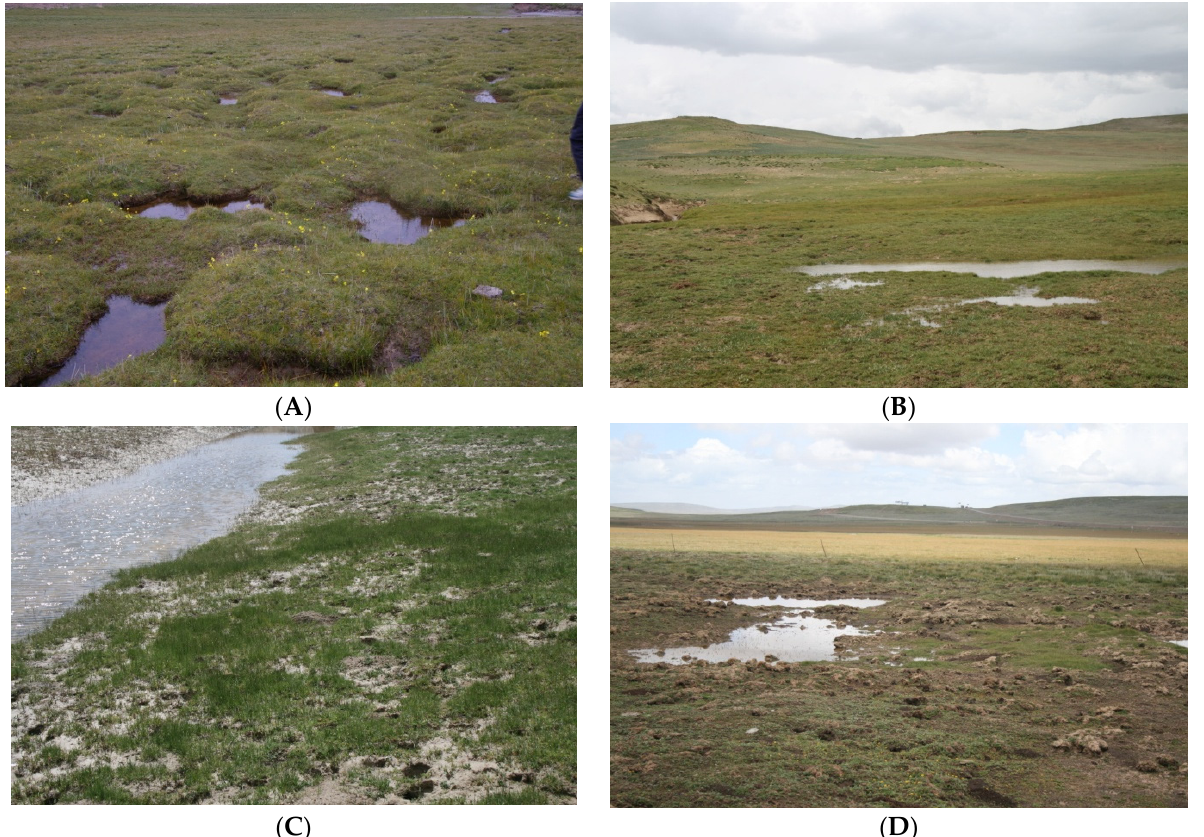
Figure 2. Typical severity levels of swampy meadow degradation in the study area. The original state ( A ) can be used as the reference state against which the severity level of degradation is judged (Table 1). ( A ) Intact; ( B ) Slight degradation; ( C ) Moderate degradation; ( D ) Severe degradation.